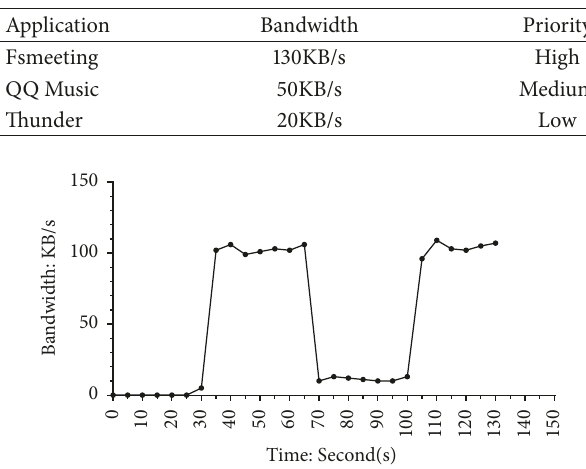
Table 1: Bandwidth and priorities configurations for the three applications.